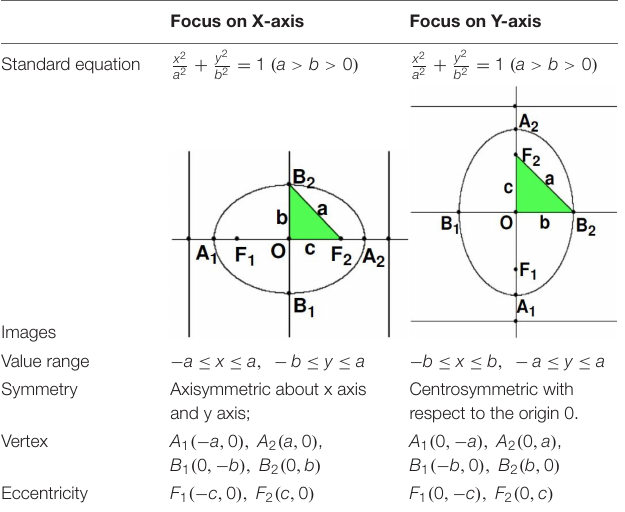
TABLE 1 | The geometry of the oval. Focus on X-axis Focus on Y-axis